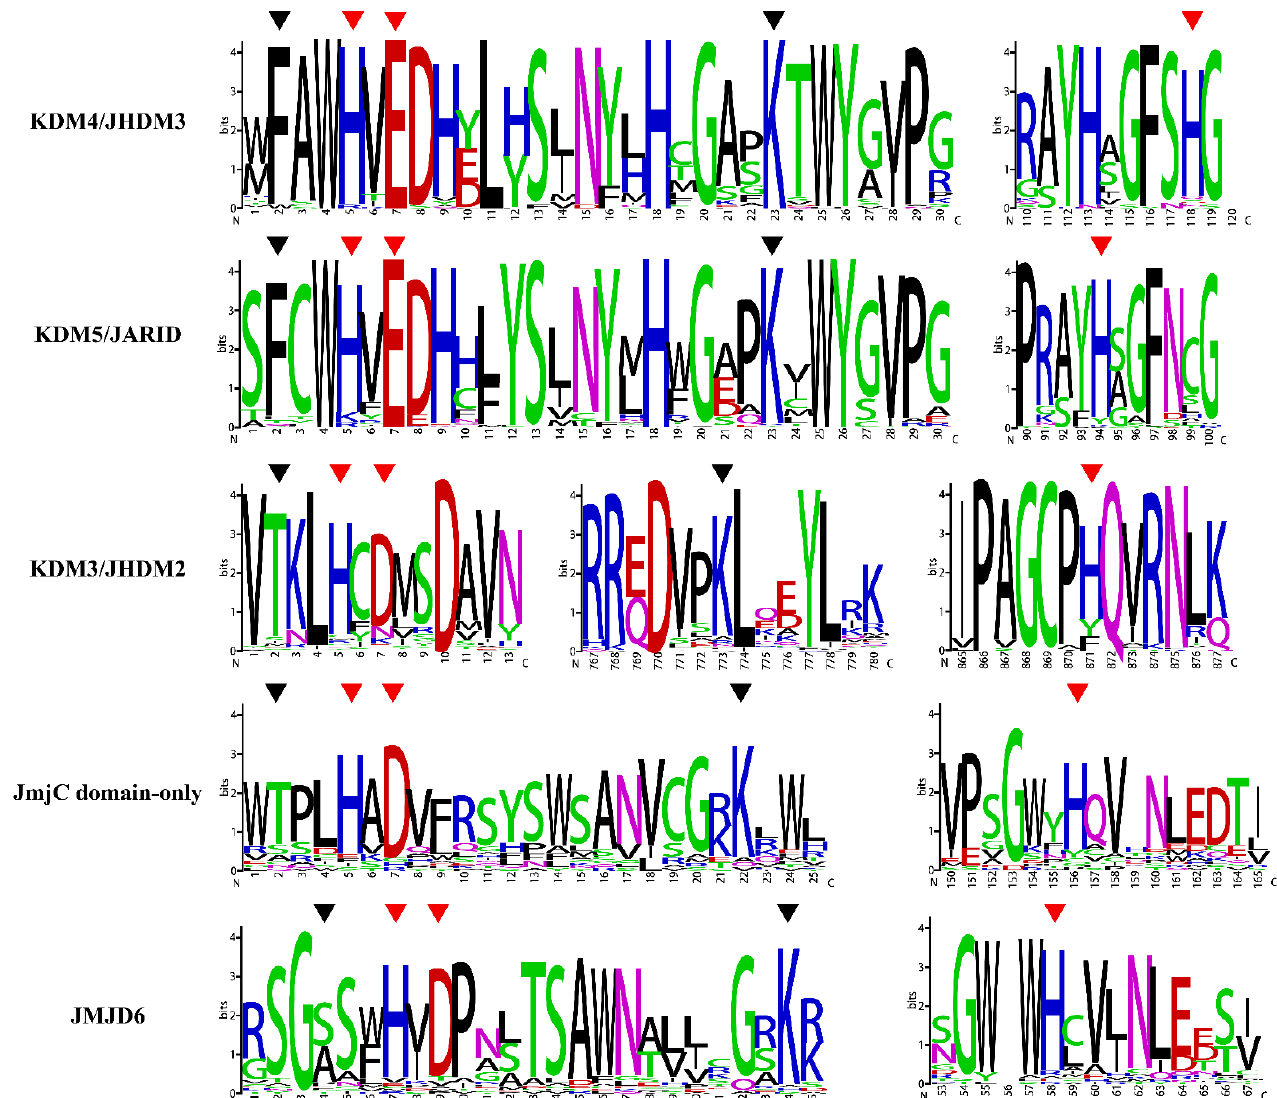
Figure 3. Conserved amino acid residues of JmjC protein in plants. The height of each letter in the figure indicates the degree of conservation of amino acid residues. The number on the abscissa indicates the relative position of the amino acid in the motif. The three conserved catalytic residues of Fe (II) (His 188, Glu/Asp 190, and His 276) are marked with red triangles. The two conserved catalytic residues of α -KG (Ther/Phe 185 and Lys 206) are marked with black triangles.